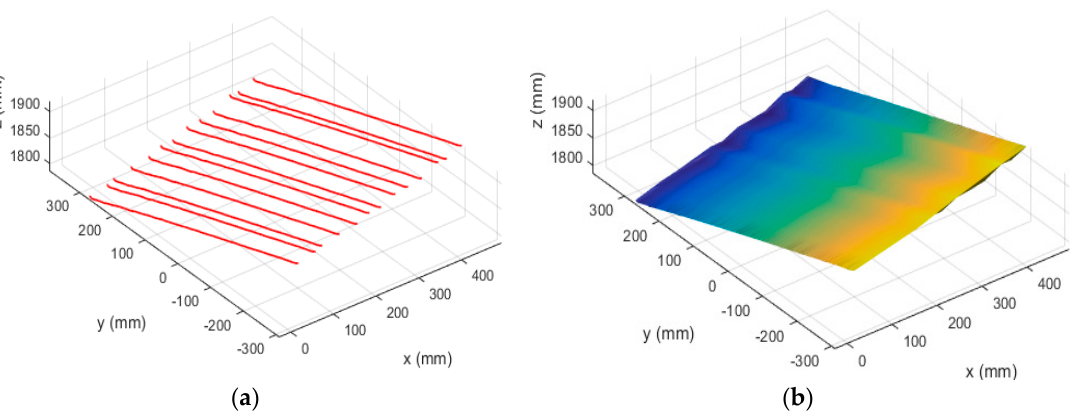
Figure 10. Reconstruction results of the flat calibration board before global optimization. Graph ( a ) shows the recovered positions of the light stripes in world coordinate system, and graph ( b ) shows the surface after triangulation and surface fitting.